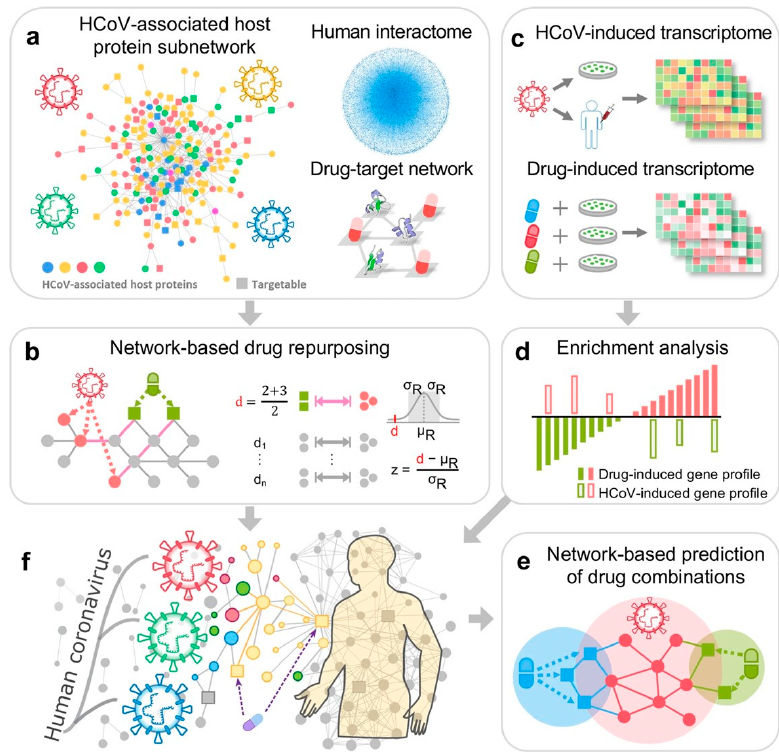
Figure 3. Network-based methodology for COVID-19 drug repurposing. ( a ) Human coronavirus (HCoV)-associated host proteins. ( b ) Network proximity between drug targets and HCoV-associated proteins. ( c , d ) Gene set enrichment analysis to validate the network-based prediction. ( e ) Drug com- binations using network-based method. ( f ) Overall hypothesis of the network-based methodology. From [54], under open access (CC